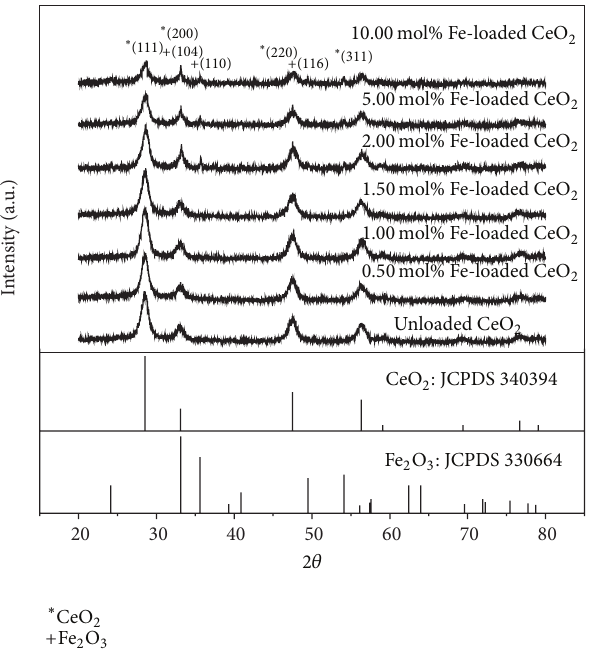
Figure 1: X-ray diffraction patterns of CeO 2 with different iron